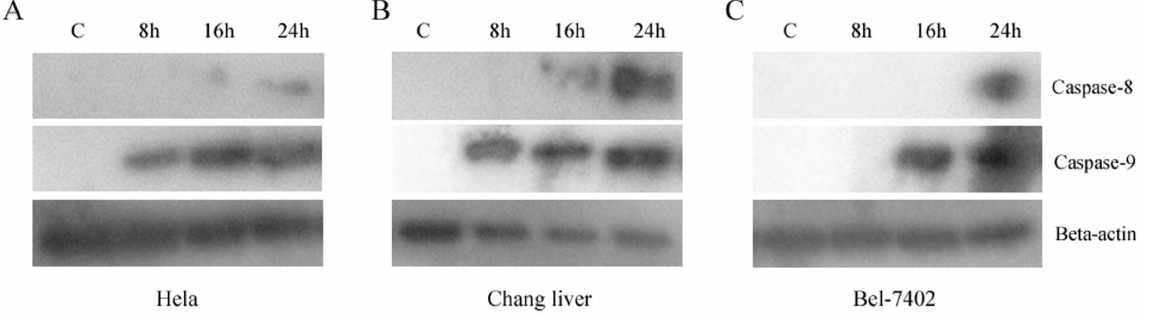
Figure 5. Western-blot analysis on activated Caspase-8 and Caspase-9 level. A . Activated Caspase-8 and Caspase-9 level in Hela cells when treated with T-2 toxin at the concentration of LC50 for 8, 16, and 24 h respectively. B . Activated Caspase-8 and Caspase-9 level in Changliver cells were treated with T-2 toxin. C . Bel -7402 cells were treated with T-2 toxin.